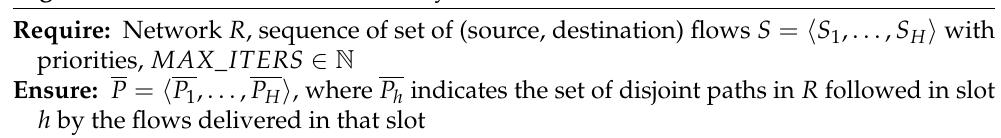
Algorithm 6 Multistart Ad-Hoc Greedy